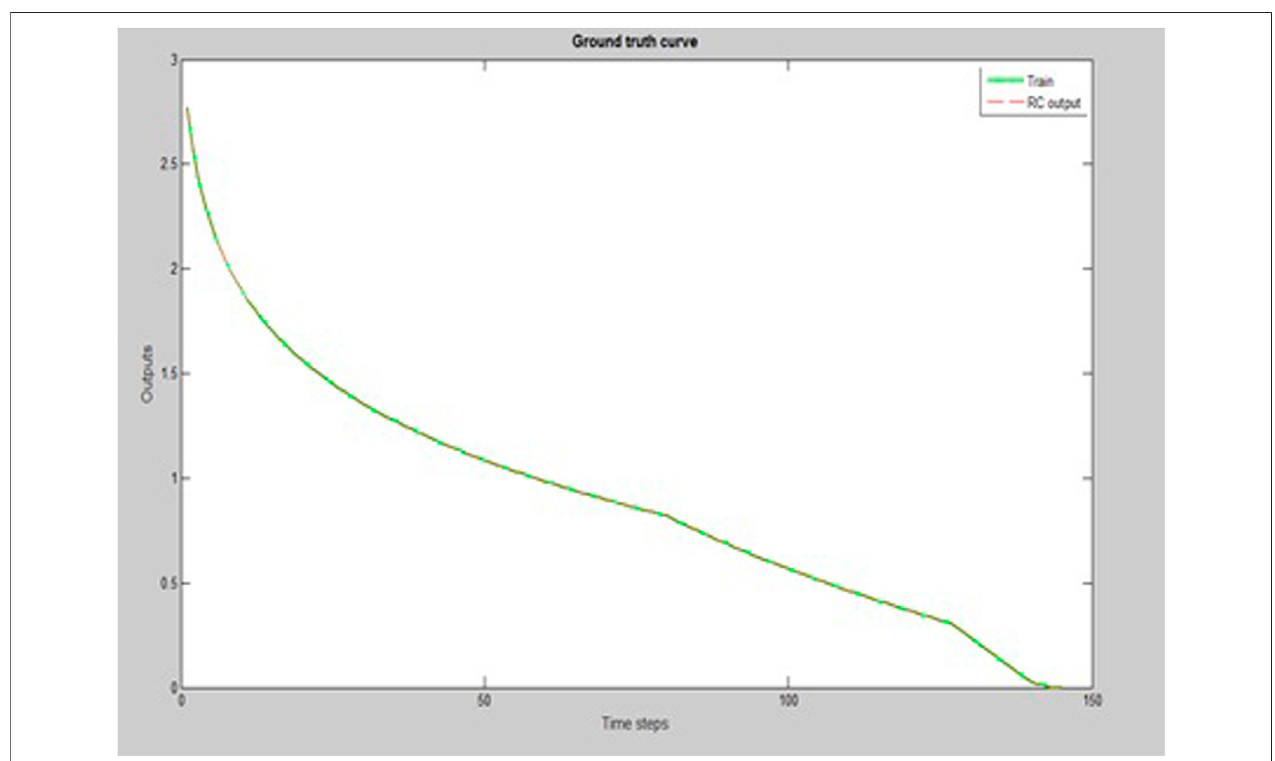
FIGURE 11 | Ground truth curve showing the output of RC-MPPT.